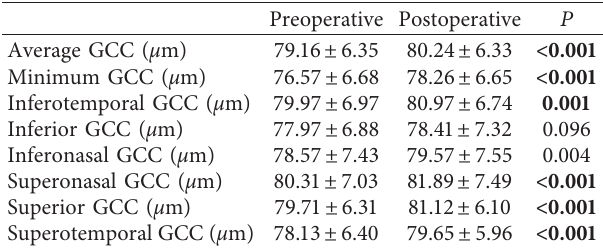
Table 3: Pre- and postoperative values of ganglion cell complex (GCC) for femtosecond laser-assisted cataract surgery.